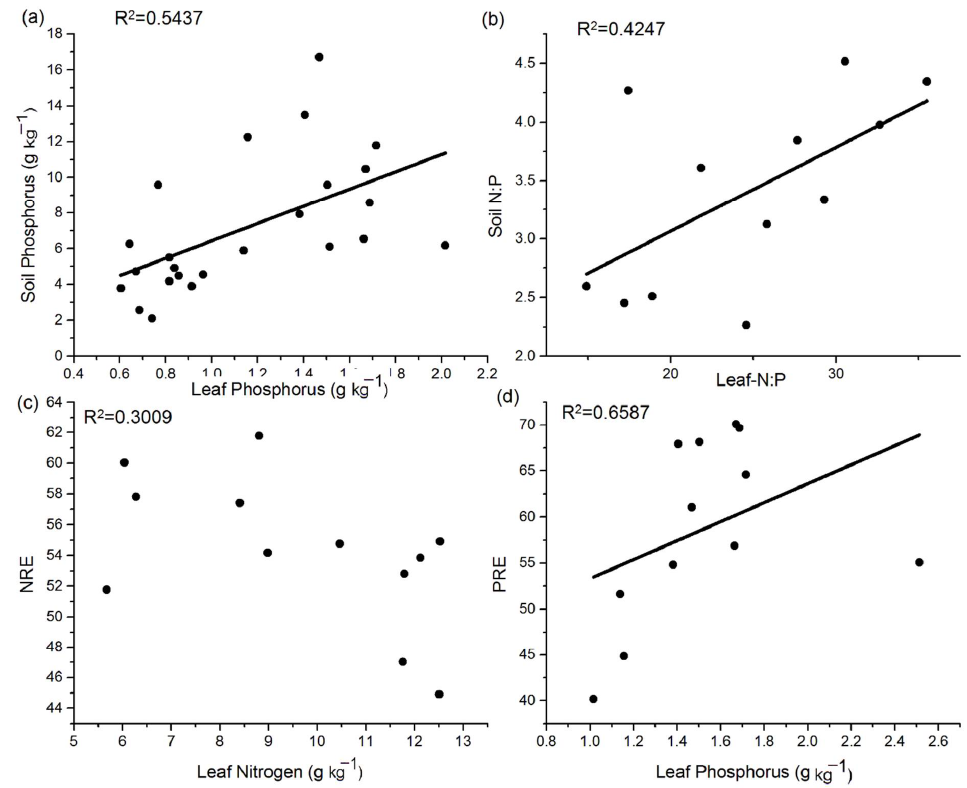
Figure 7. Relationship between ( a ) tree and soil stoichiometry, ( a ); R 2 = 0.5437, p = 0.000: ( b ); R 2 = 0.4247, p < 0.005 ( c ) Nutrient resorption efficiency and leaf stoichiometry, (NRE-nitrogen resorption efficiency) R 2 = 0.3009, p = 0.6314: ( d ); (PRE-phosphorus resorption efficiency) R 2 = 0.6587, p < 0.001, in P. massoniana chronosequence.